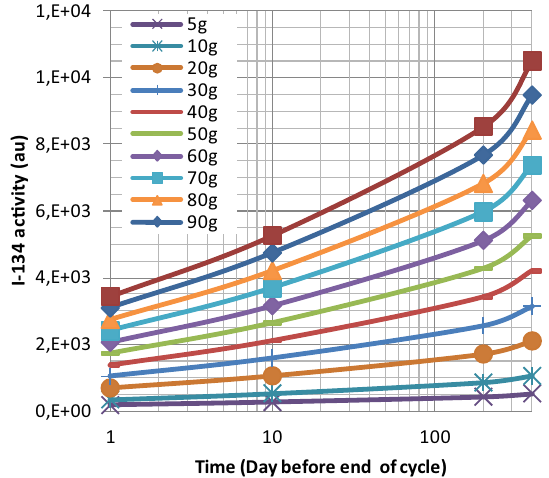
Fig. 8. Example of abacus developed using OSCAR code for the assessment of the quantity of disseminated fi ssile material in the case of fuel